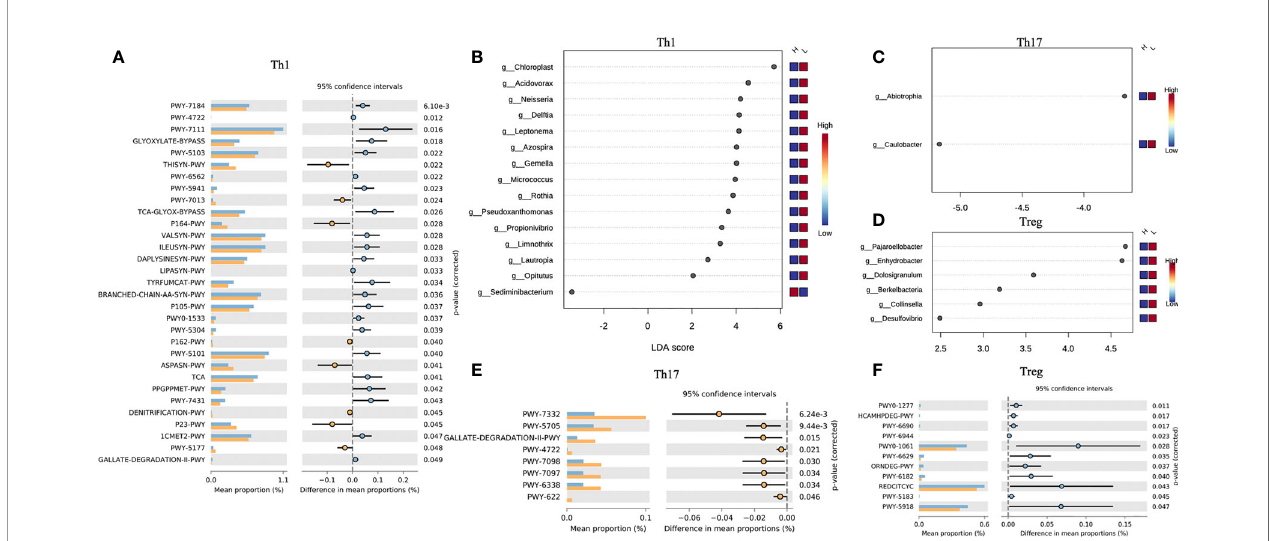
FIGURE 5 | Interaction between T cell subtypes and microbiota. Comparison of differences in metabolic pathway of Th1 (A) , Th17 (E) , and Treg (F) . Different genera related to Th1 (B) , Th17 (C) , Treg (D)